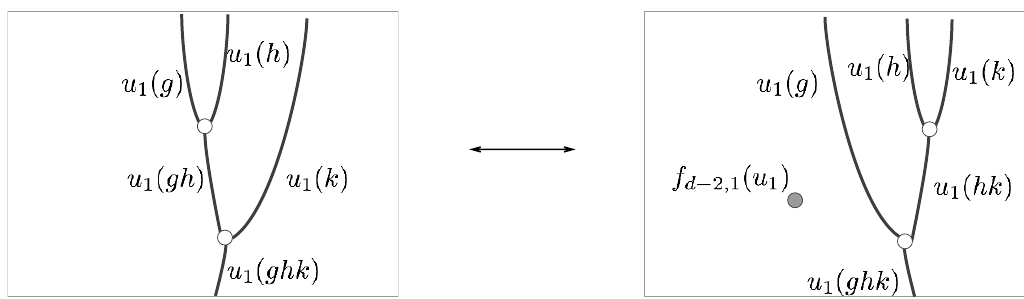
Figure 10 . Failure of associativity for reference